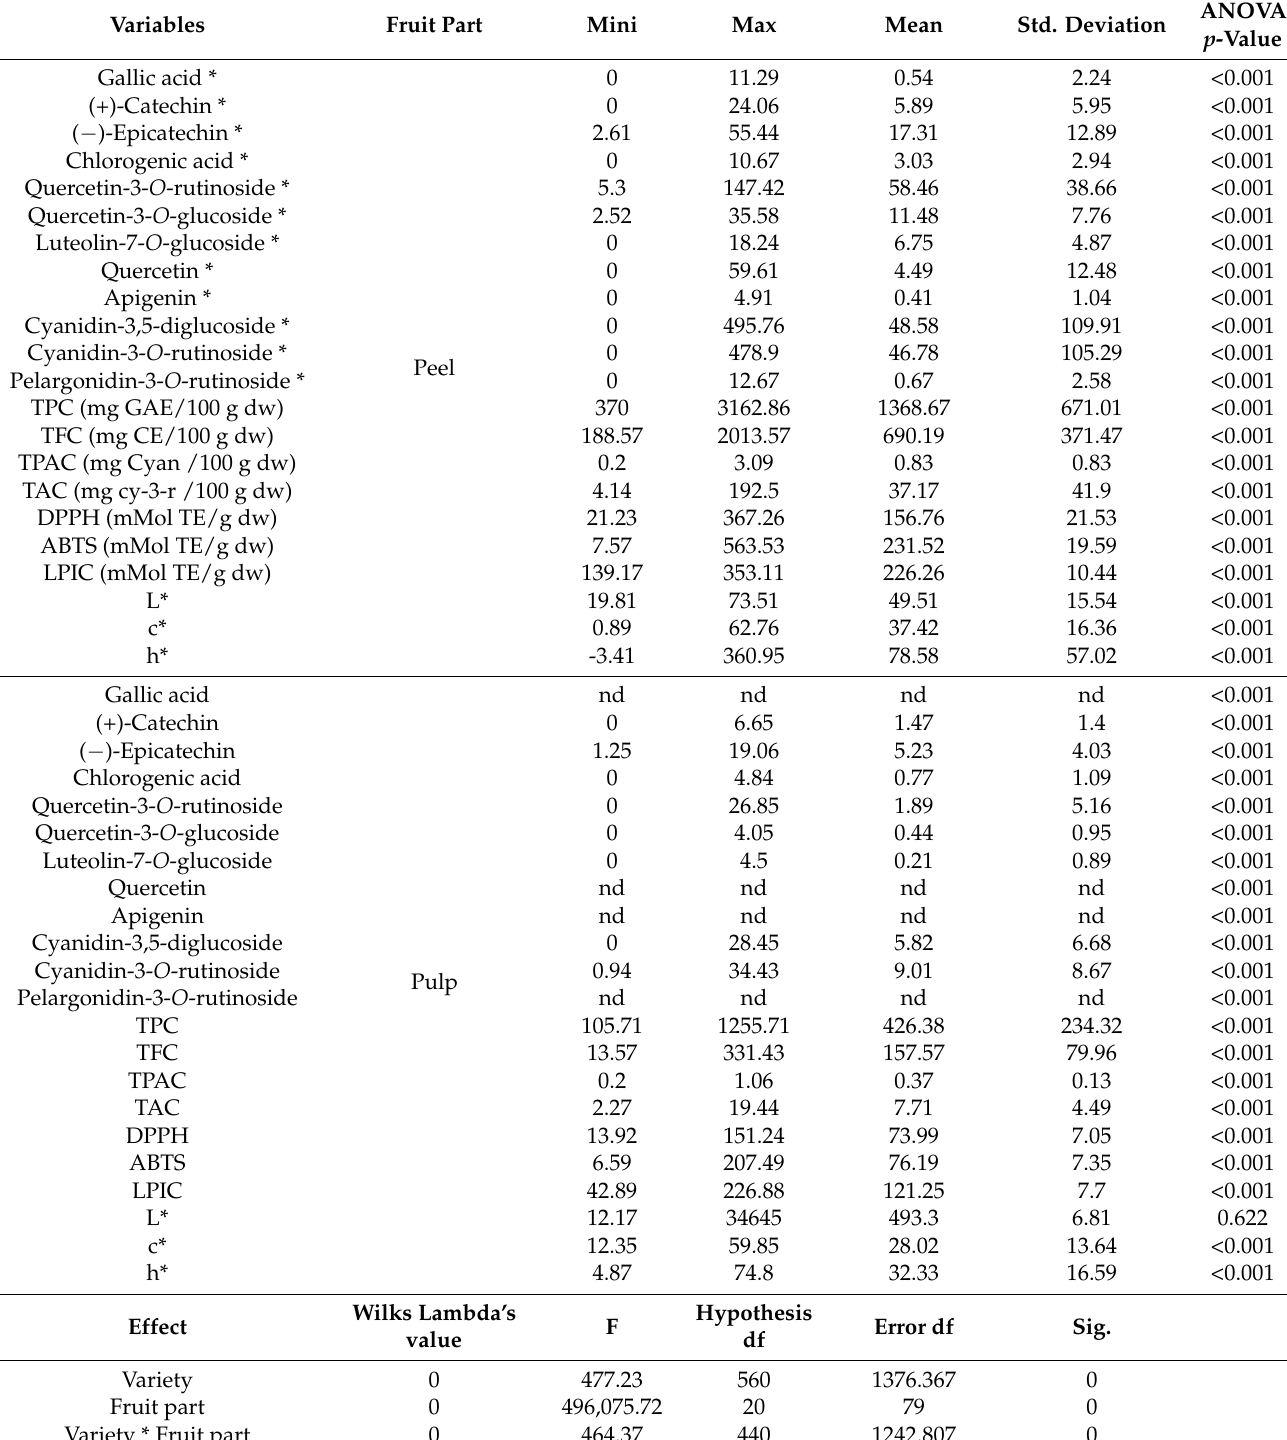
Table 1. Descriptive analysis and multivariate analysis of variance of all studied variables over figs’ peels and pulps.